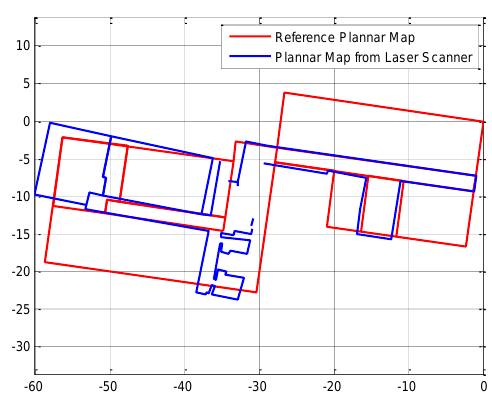
Figure 12. The comparison between reference map and